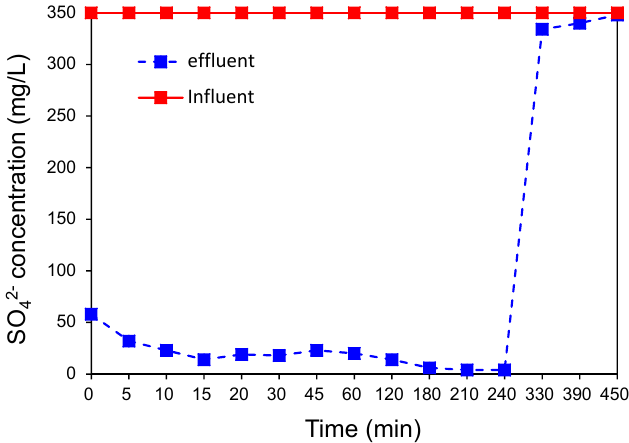
Figure 9. Sulfate concentration in NOM samples in influent and effluent of PCL/Ba (10/90) packed columns (Diameter: 2.25 cm).